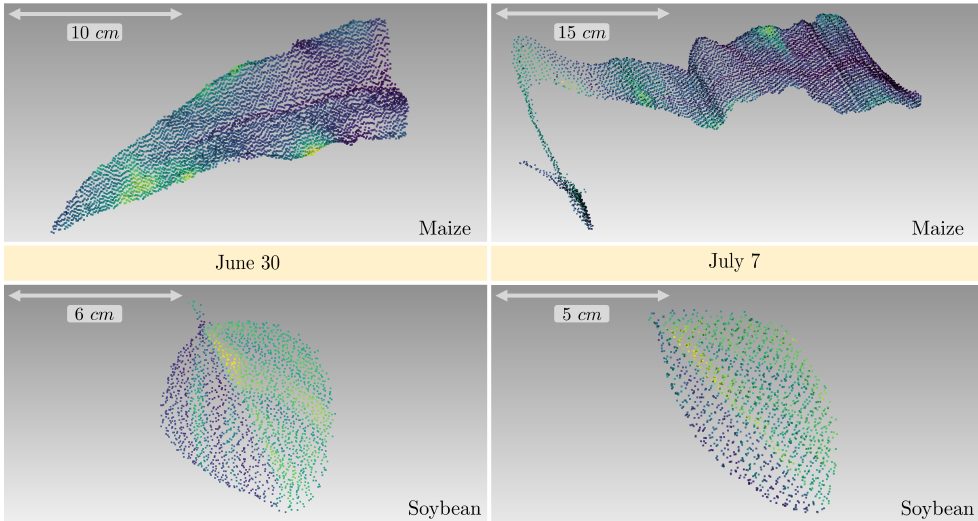
Figure 11. Example maize and soybean leaf scanned at different days within the growing season. On 30 June less wind effects in the field were present. On 7 July dynamic wind conditions prevail in the